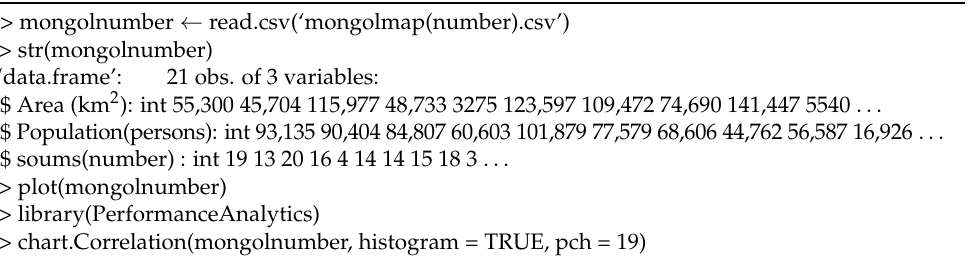
Table 6. Correlation big data analysis for each province in Mongolia’s script.